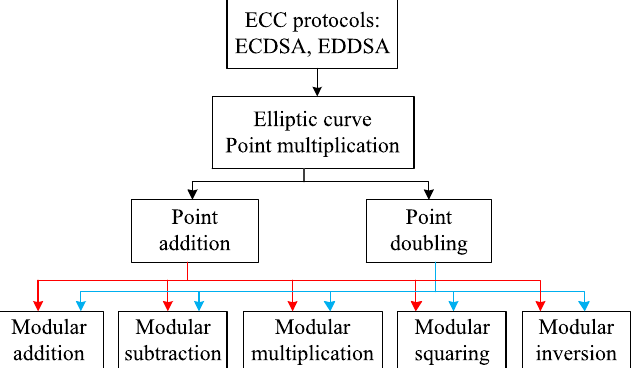
Figure 1. Hierarchy of elliptic curve